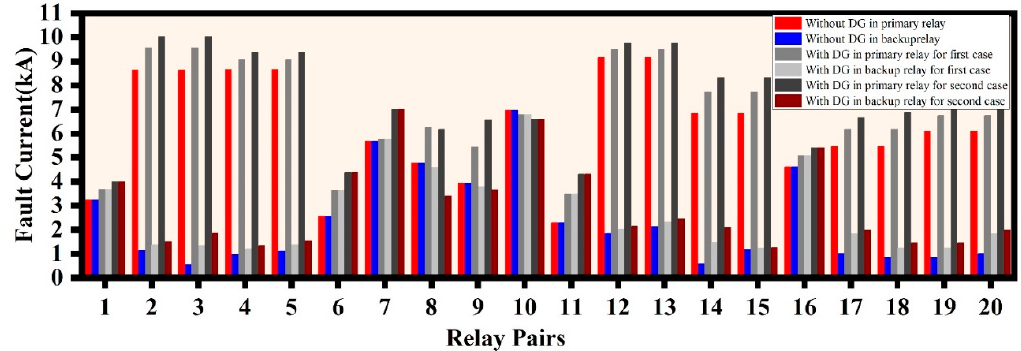
Figure 11. Fault currents in primary and backup relays without distributed generation (DG) and with (DG) for both cases. Table 4. Relay settings obtained with particle swarm optimization (PSO)–LP and HHO–LP for IEEE- 8 bus system at a wind speed of 10 m/s. TMS, time multiplier setting.